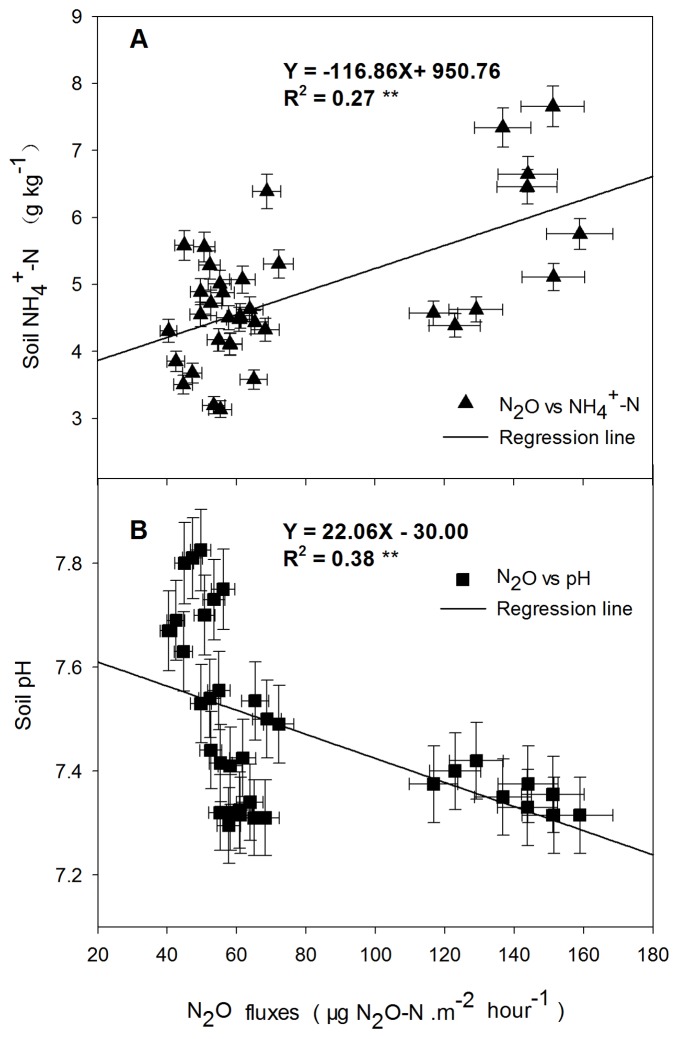
A Linear regression between the N2O emission fluxes and soil NH4
+-N, B Linear regression between the N2O emission fluxes and soil pH.Arrows indicate the regression equation between the N2O emission fluxes and soil NH4
+-N, soil pH. **indicates P<0.01.